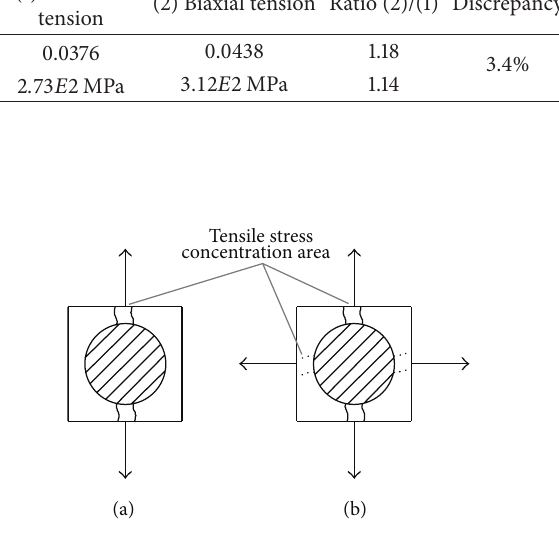
Figure 7: Stress concentration areas in uniaxial and biaxial tension load cases—orientation 1.